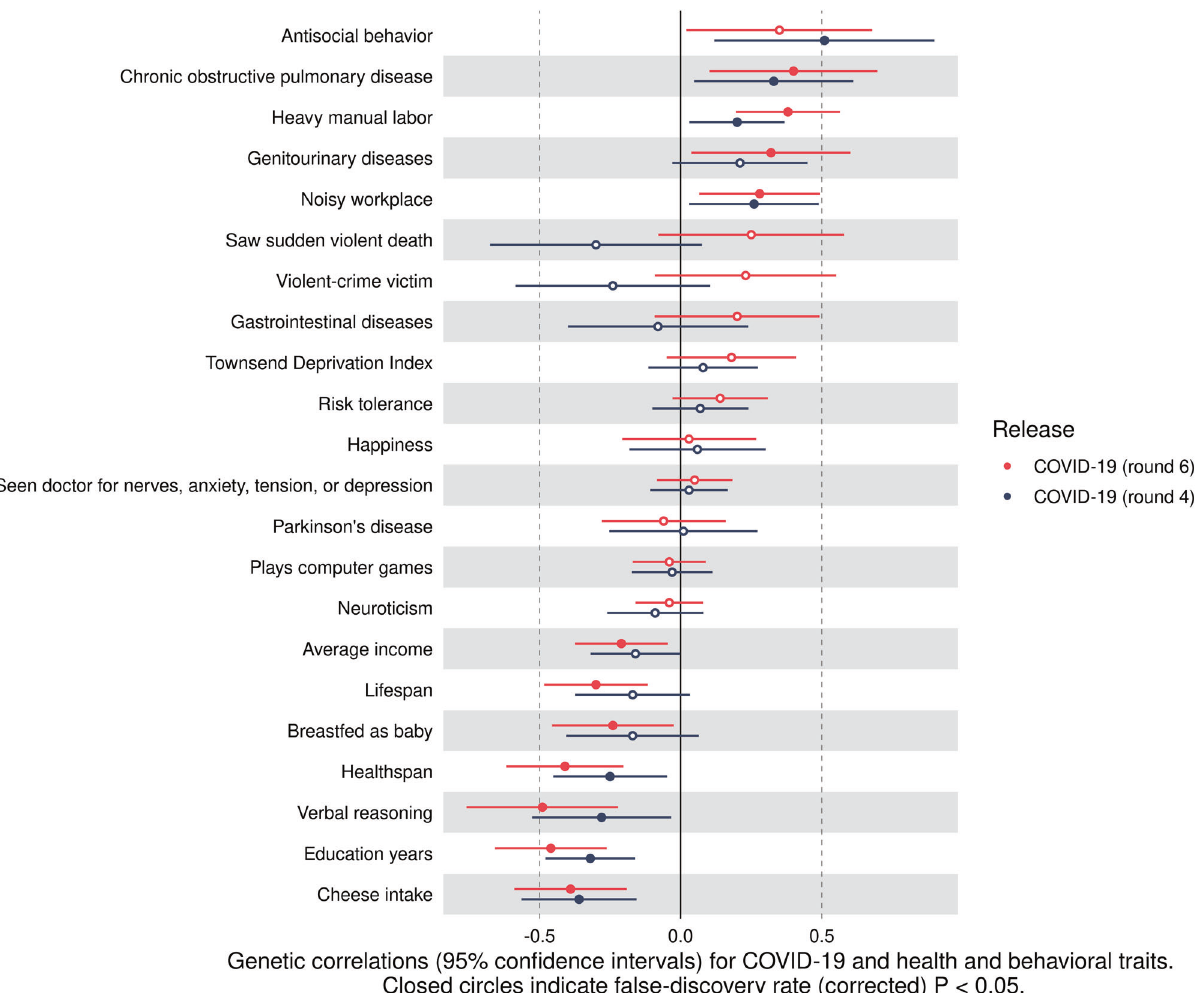
discovery rate (corrected) P -values